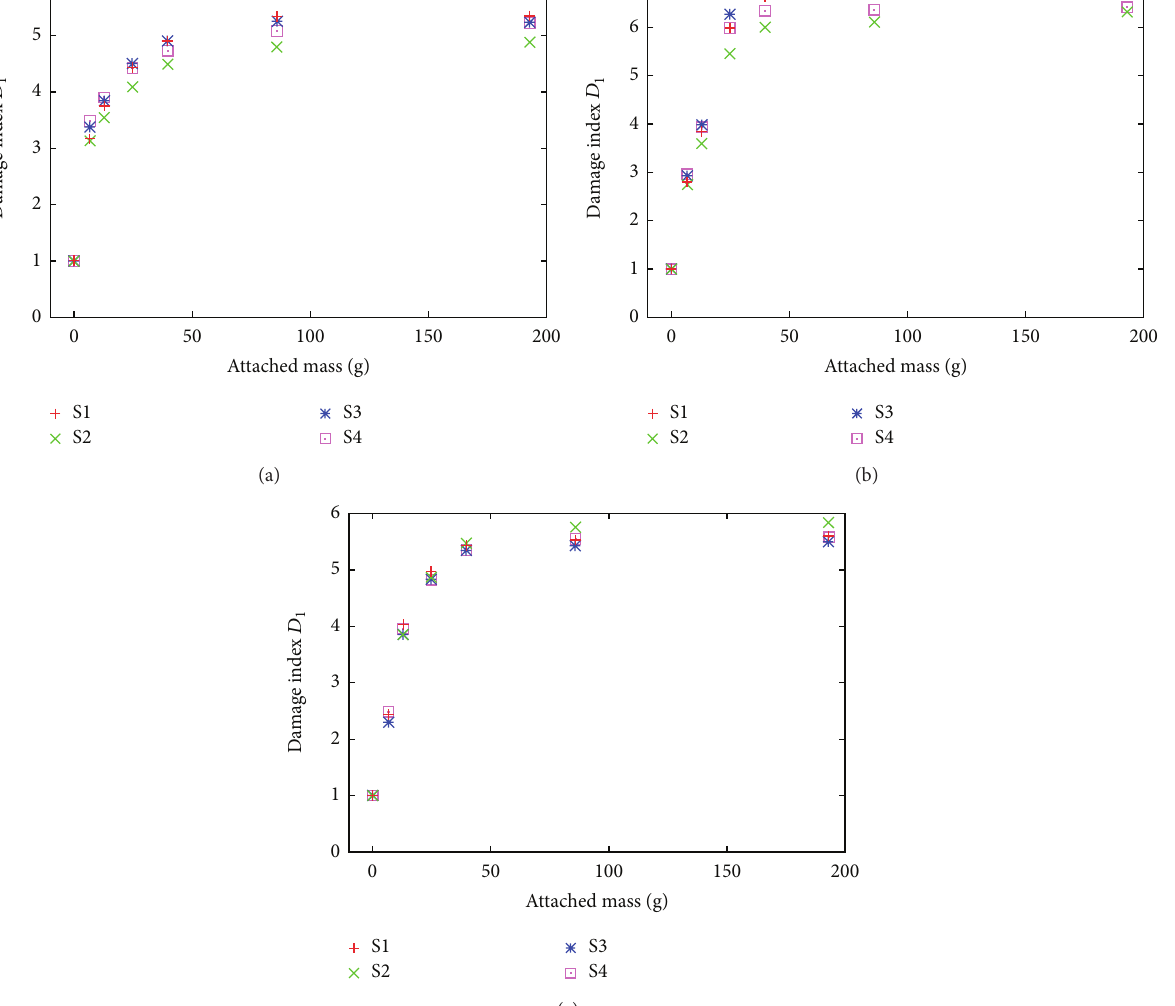
Figure 5: Variation of 𝐷 1 with attached mass. (a) Damage in position P1. (b) Damage in position P2. (c) Damage in position